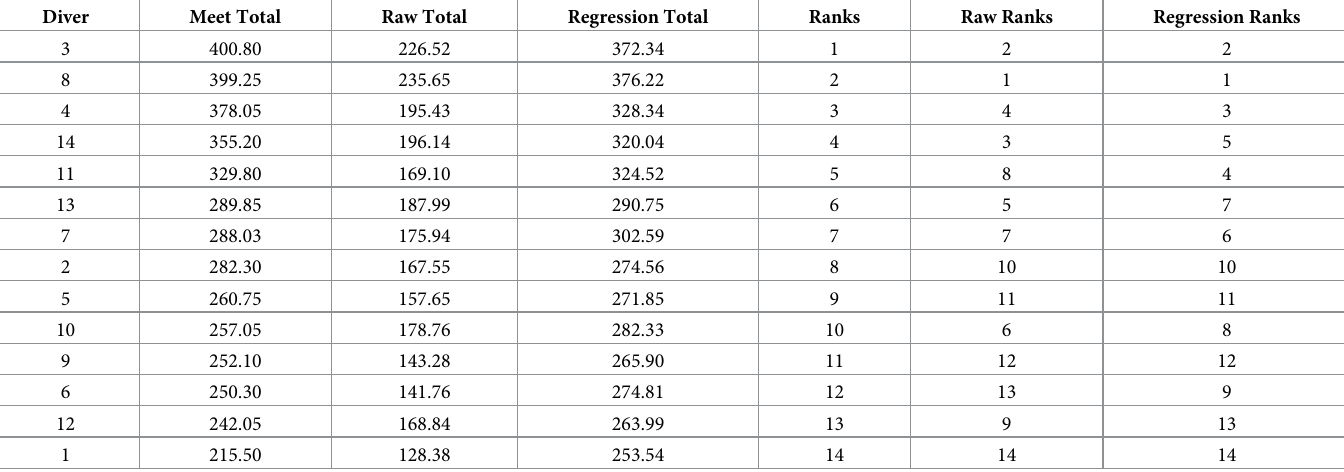
Table 4. Actual scores and rankings of all female divers compared with rankings from using the raw measurements and the regression model. Diver Meet Total Raw Total Regression Total Ranks Raw Ranks Regression Ranks 226.52